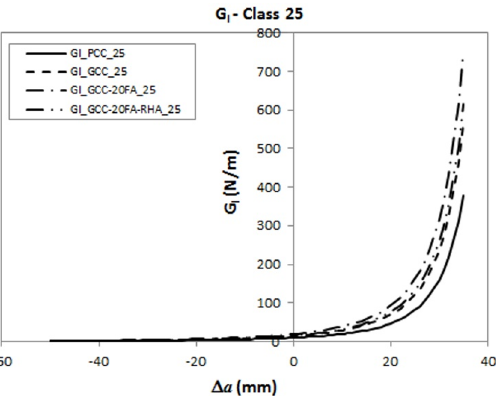
Figure 6. Variation of the rate of deformation energy release with the extension of the crack for concrete notched beams of strength class of 25 MPa with different matrices.